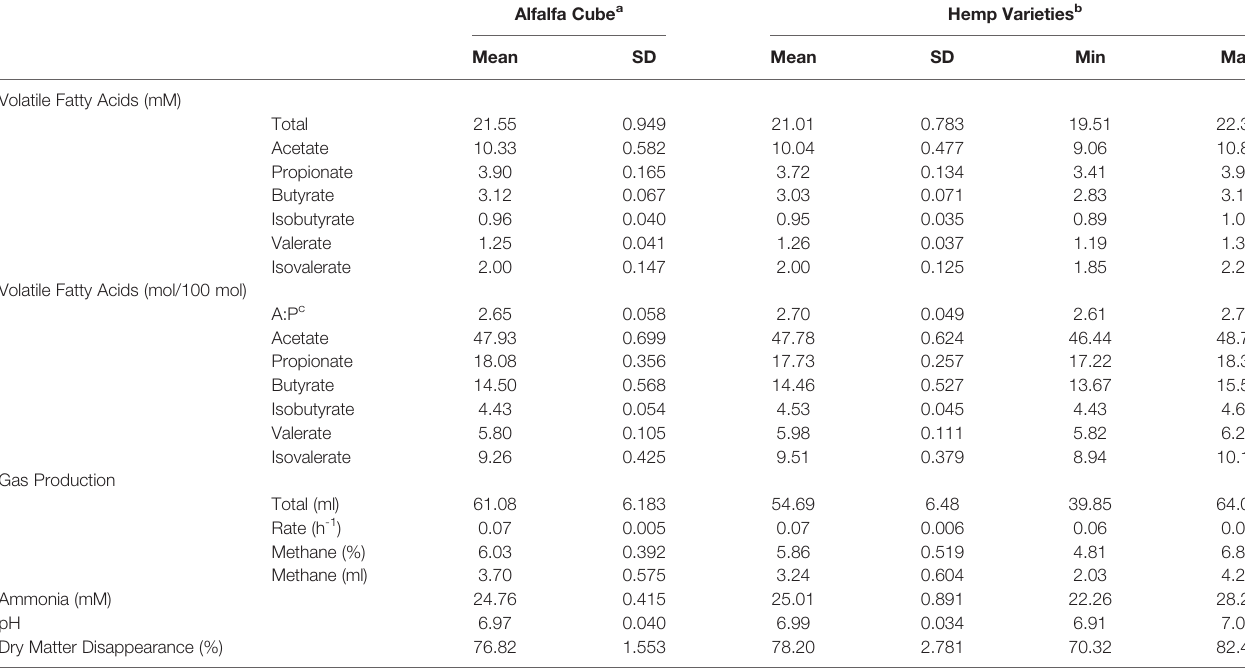
TABLE 6 | Descriptive statistics for in vitro products of digestion of in fl orescence from 9 CBD-extracted hemp cultivars after 48-h digestion period. Alfalfa Cube